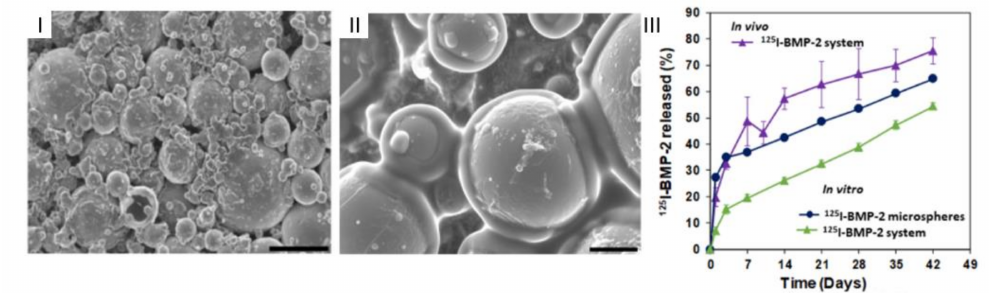
Figure 13. Microparticles embedded in a hydrogel: ( I ) composite system freshly prepared (scale 100 µ m); ( II ) composite system after 4 weeks in water (37 ◦ C, 25 rpm); ( III ) release tests of BMP-2: in vitro: from microparticles (blue) and the composite system (green), in vivo: composite system (purple). (Adapted with permission from [77]. Copyright (2021)